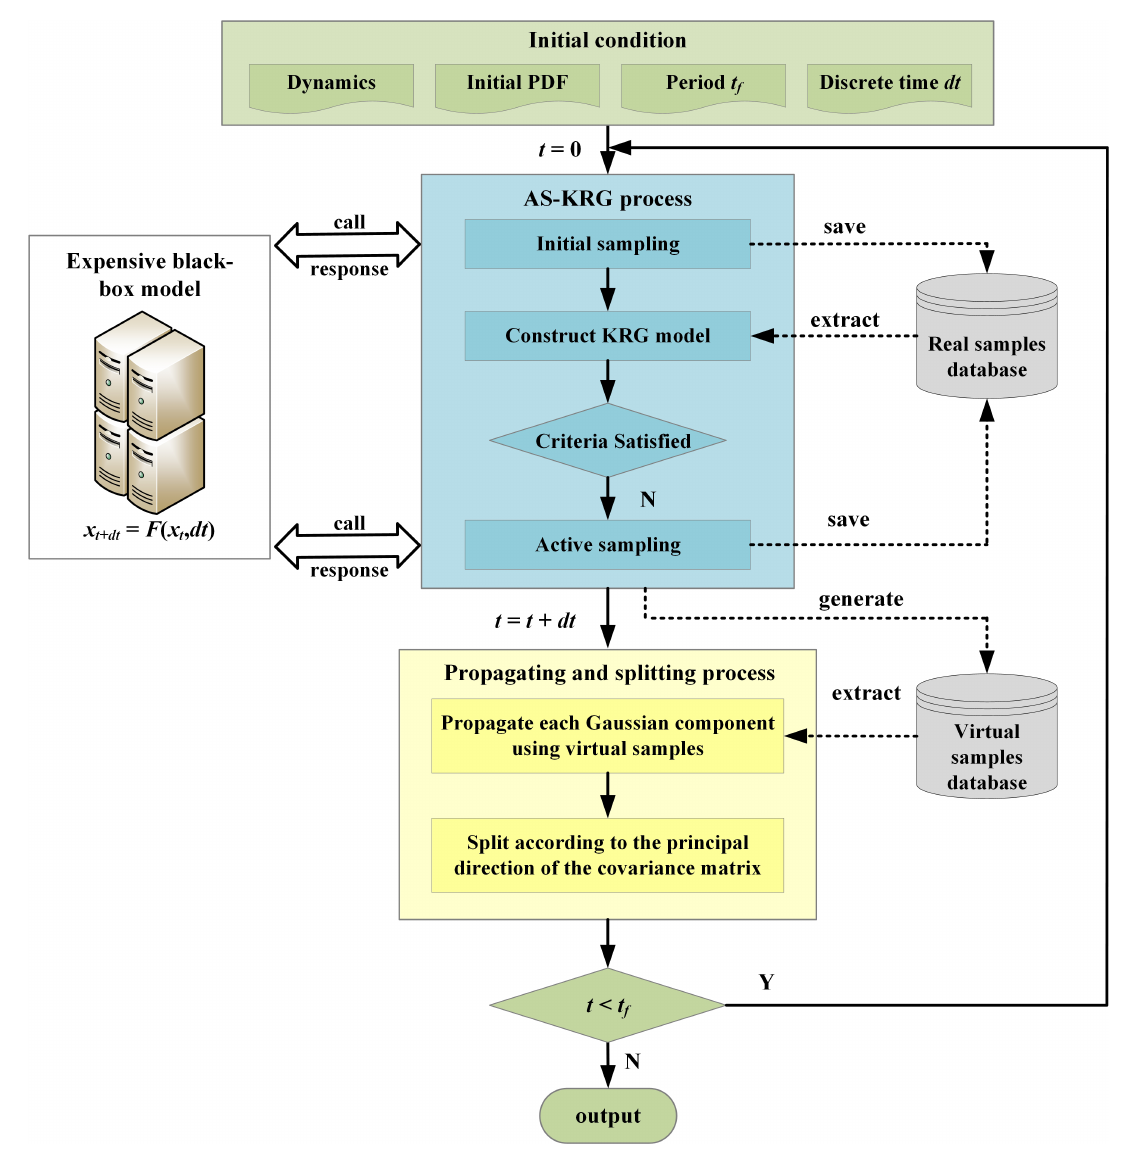
Figure 1. Flowchart of